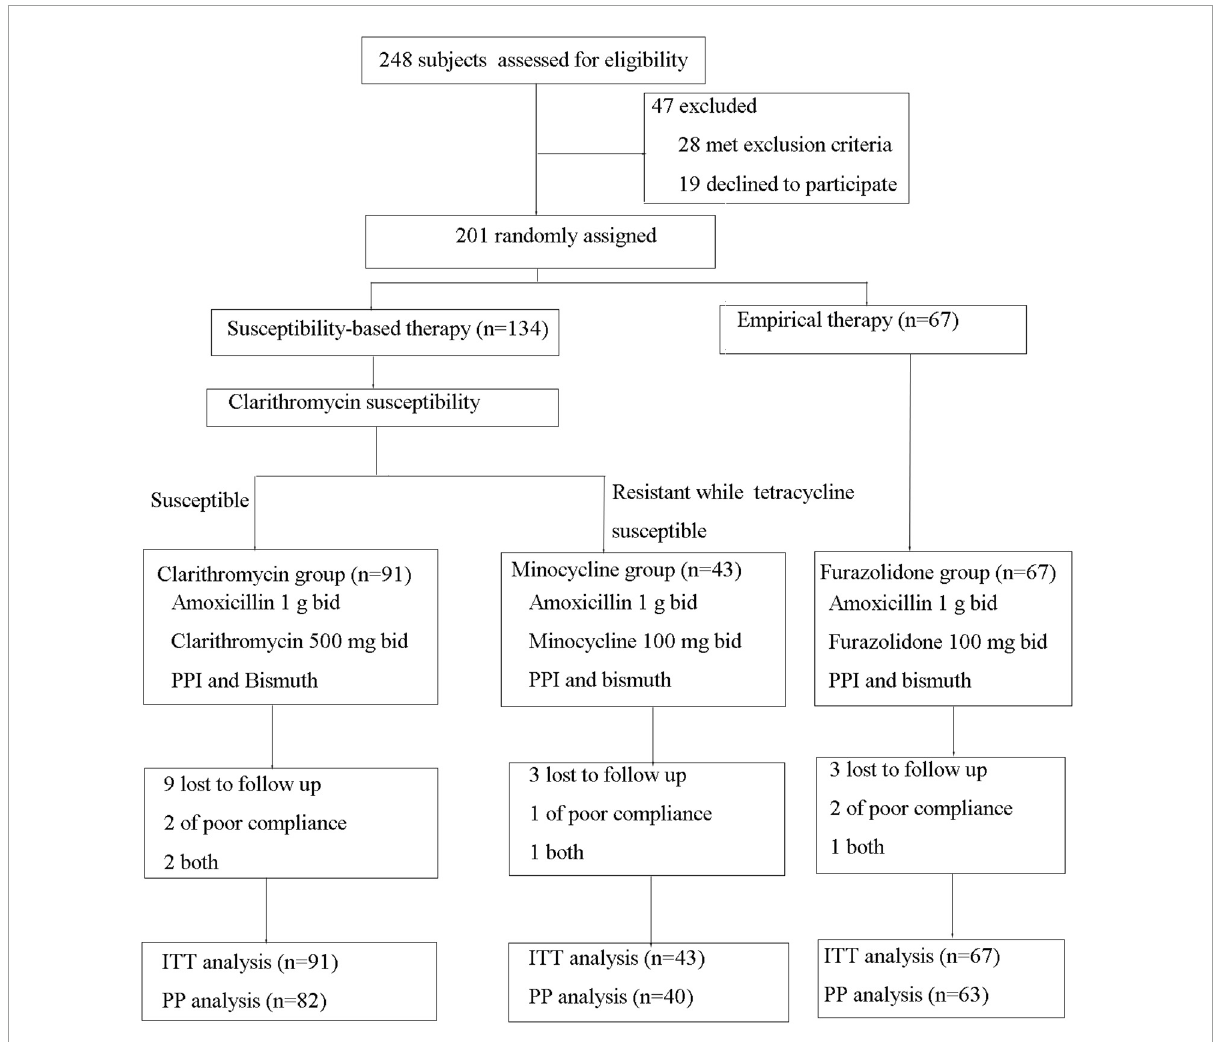
FIGURE1 Flow diagram of the